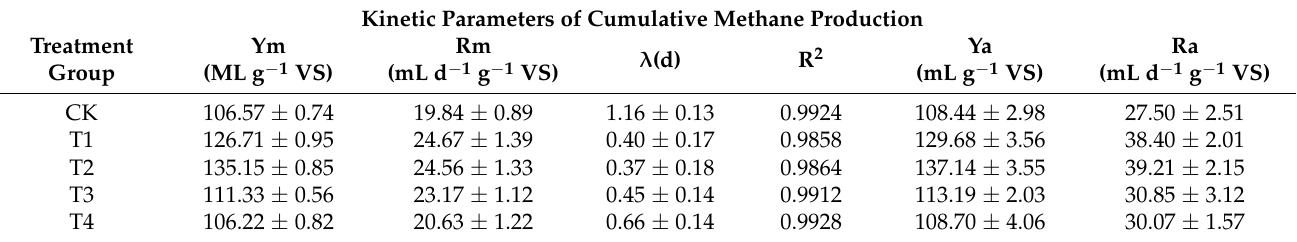
Table 2. Fitting results of cumulative methane production in the anaerobic digestion process. Kinetic Parameters of Cumulative Methane